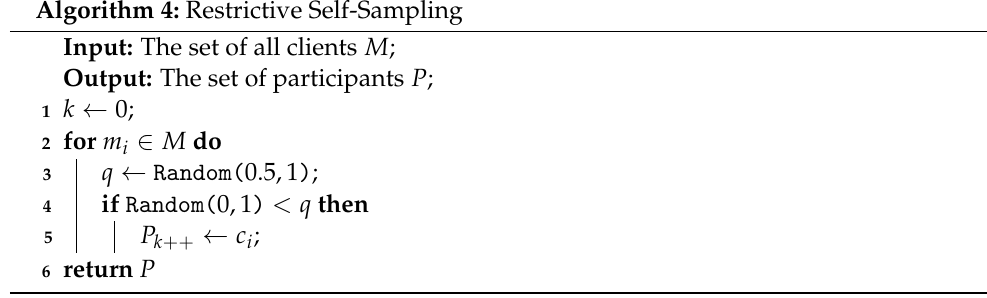
Algorithm 4: Restrictive